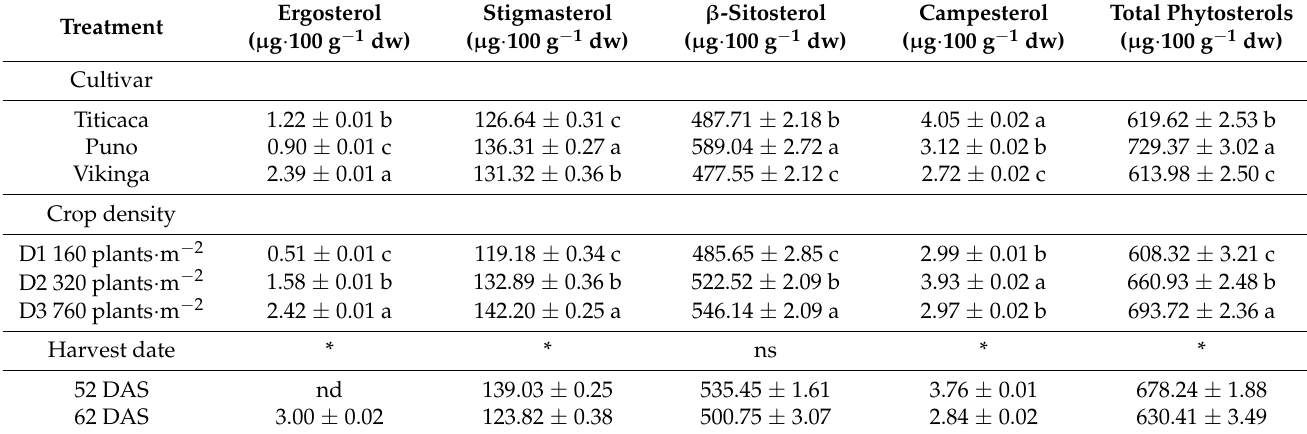
Table 5. Cultivar, plant density and harvesting time effect on phytosterol compounds of quinoa leaf